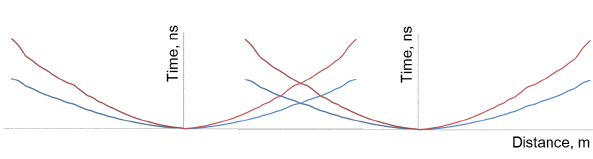
Figure 5. Unusual event from HT data. Figure 3. EAS disk width at di ff erent distances from axis at the observation level.